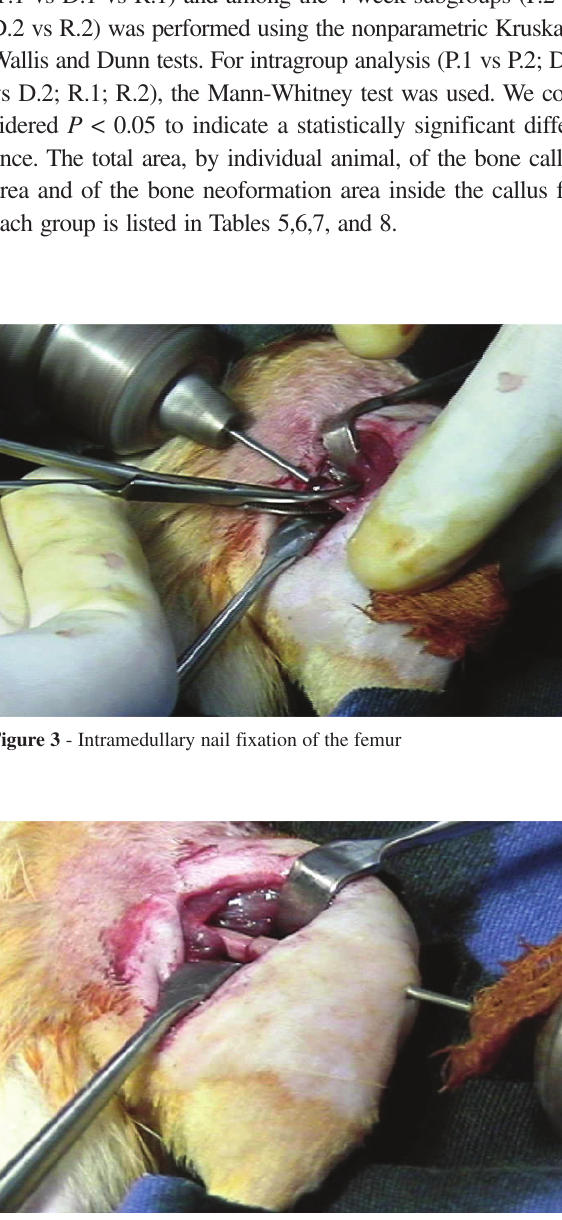
Figure 2 - End of the femur osteotomy with manual saw